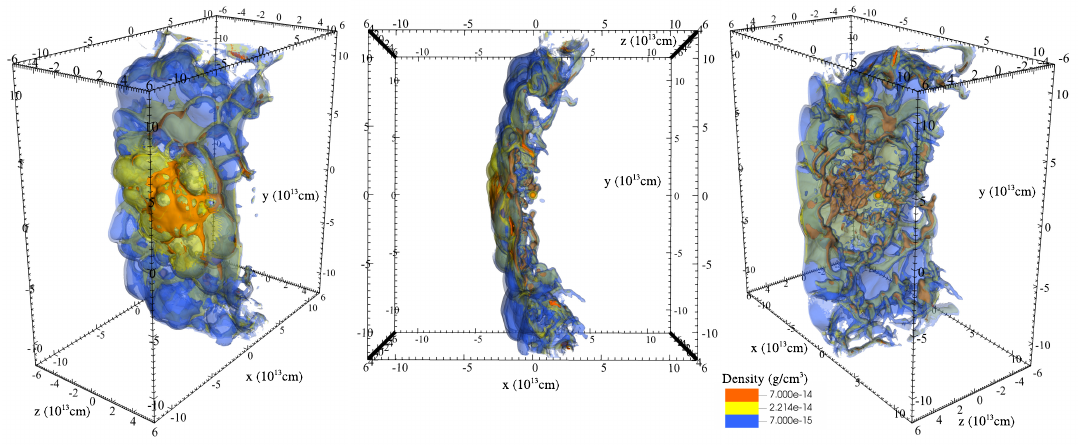
Figure 1. The density of the wind for the simulations we run observed from 3 directions (our fiducial Run 1). The primary and the secondary are not shown. The side facing the secondary has finer clumps and filaments than the side facing the